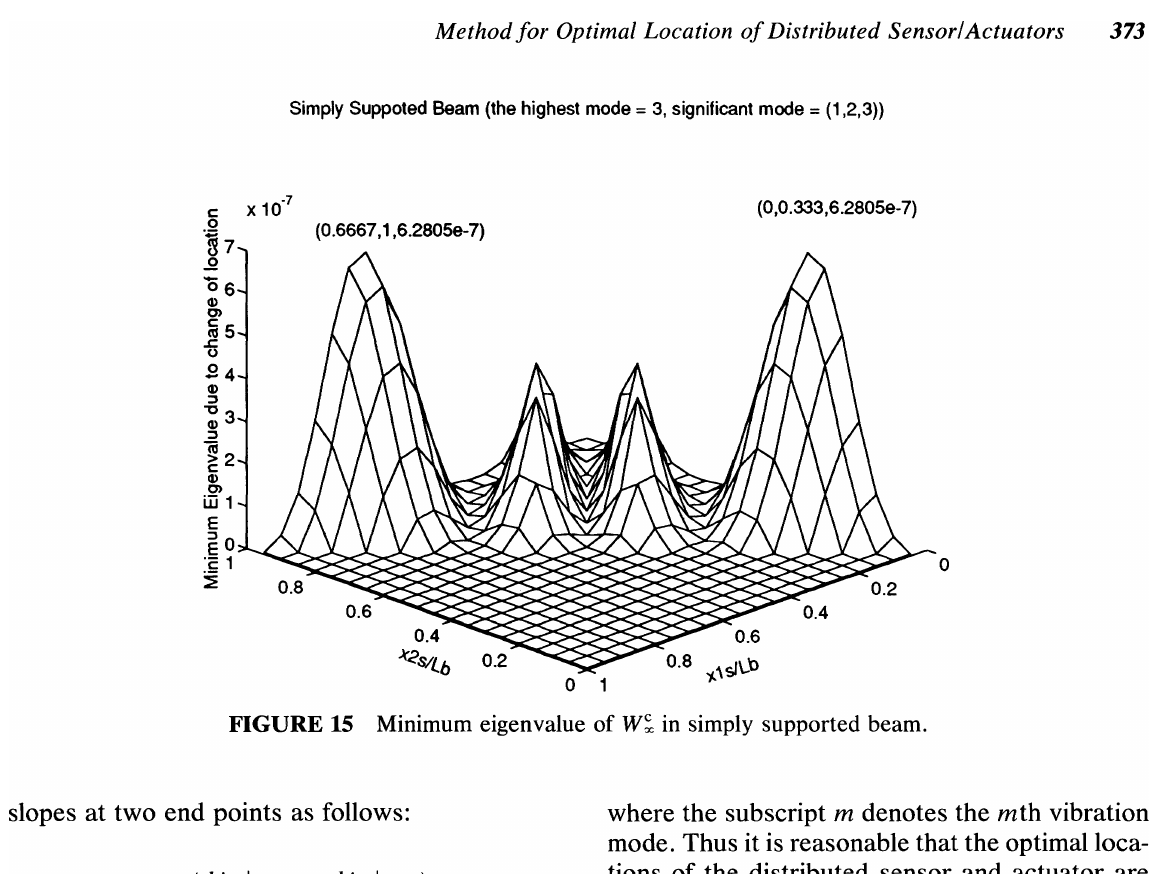
FIGURE 15 Minimum eigenvalue of W~ in simply supported beam.